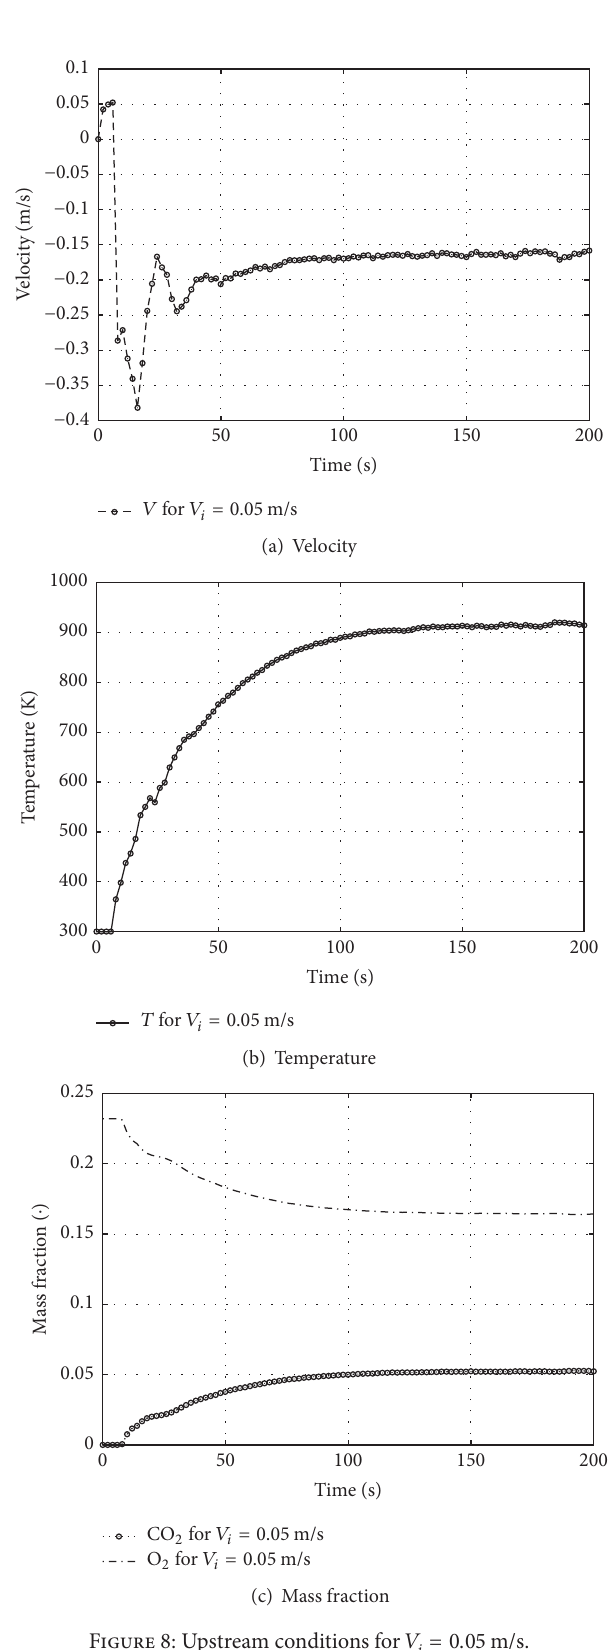
Figure 8: Upstream conditions for 𝑉 𝑖 = 0.05